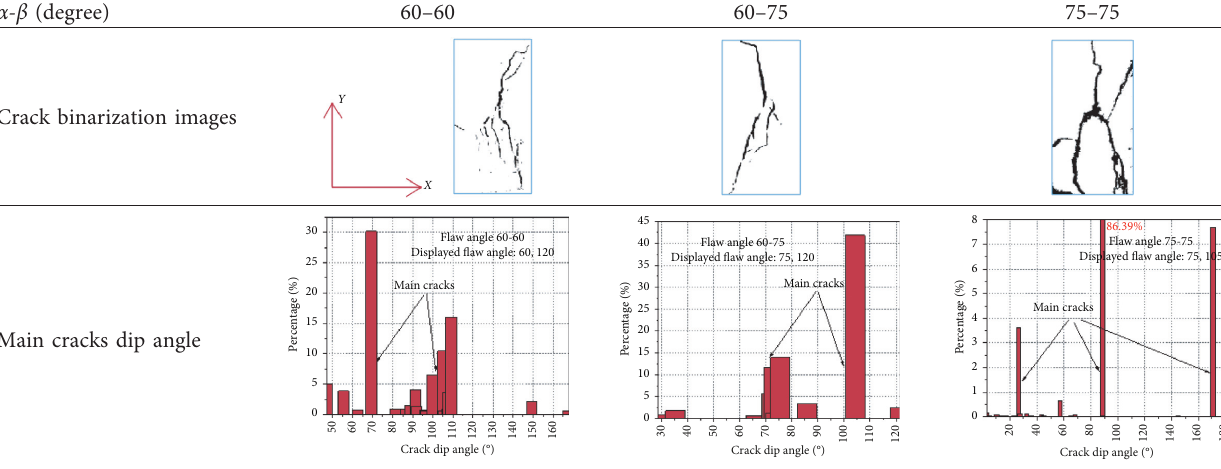
Flaw angle 75-75 Displayed flaw angle: 75, (°)Main cracks